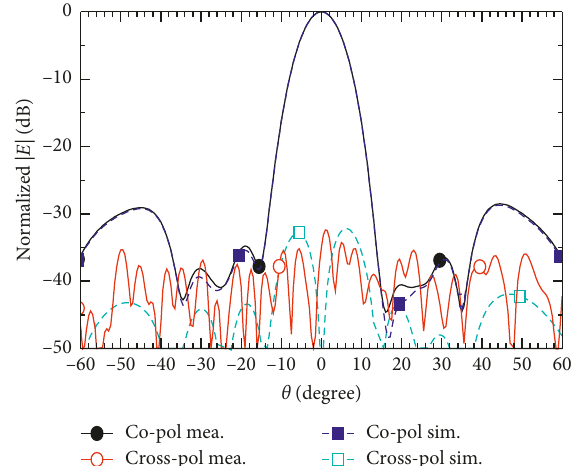
Figure 10: Measured and simulated xz -plane normalized patterns of the subarray in Mode II at 38GHz.